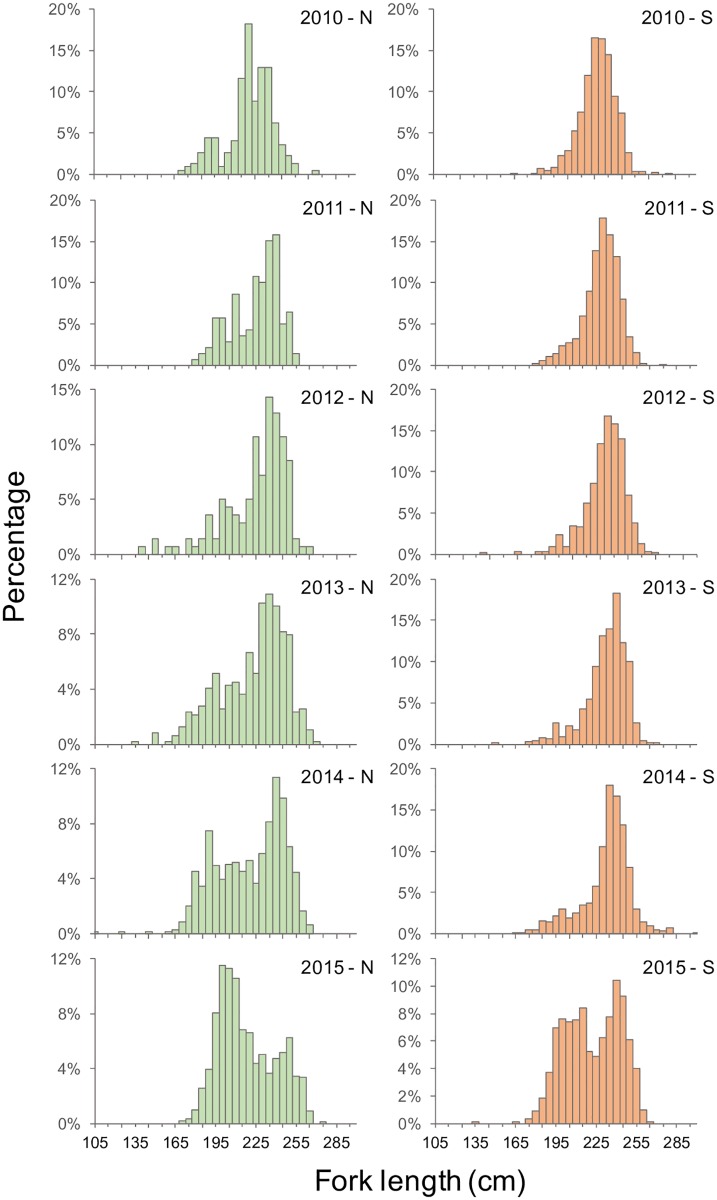
Length frequencies of PBF caught by the Taiwanese longline fishery.The length frequencies are presented as the FL in cm (bottom limit) in the northern fishing ground (left panel, green) and southern fishing ground (right panel, orange) during 2010–2015. Please refer to Fig 4 for the definition of fishing grounds. The data are provided in S2 File.